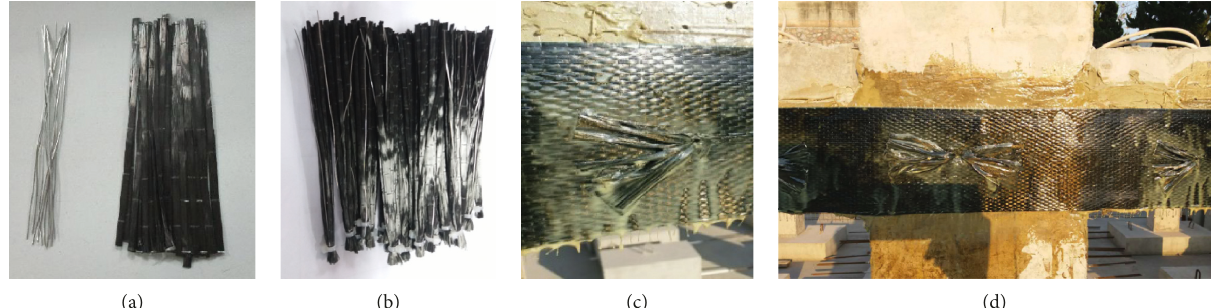
Figure 3: Details of the HFRP anchors. (a) Steel wires and carbon fibres, (b) HFRP anchors, (c) CFRP sheet and HFRP anchor, and (d) CFRP sheet anchored with HFRP anchors.